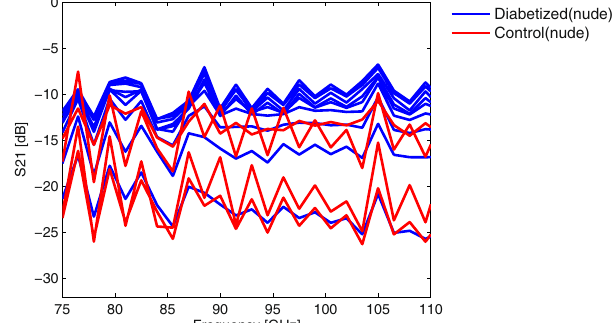
Figure 7. Amplitude of the transmission coefficient S(2, 1) versus frequency for diabetized and control mice, one week before the data in Fig.